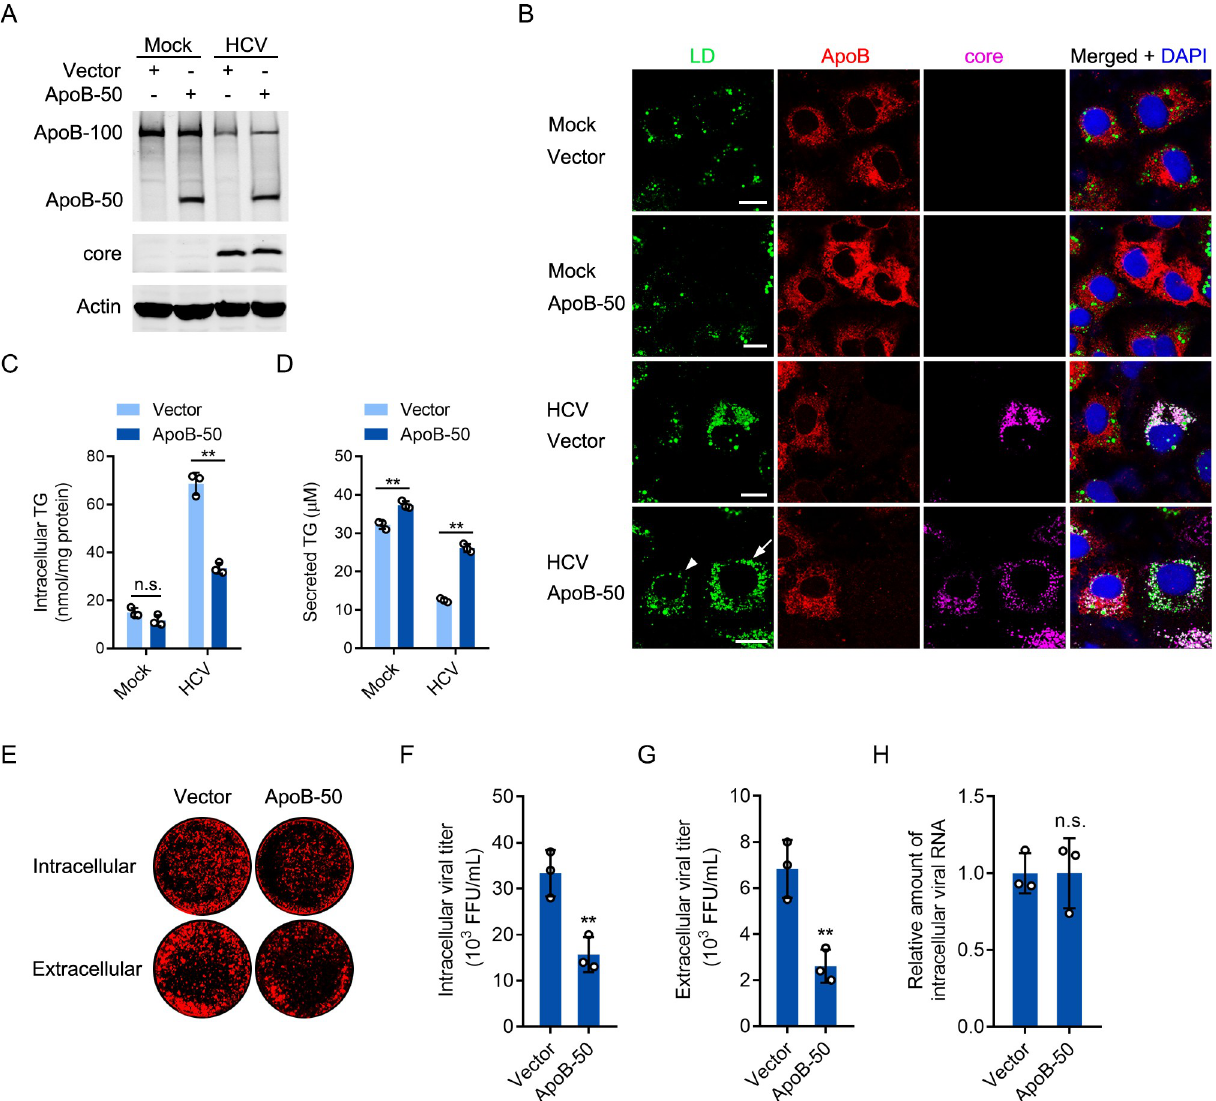
Fig 9. Expression of ApoB-50 decreased lipid accumulation and inhibited HCV production. (A) Huh-7 cells were infected with HCV (MOI = 1) for 2 days prior to transduction with ApoB-50 for 2 days. The protein levels of ApoB and the core were analyzed by western blotting. Actin was used as the loading control. (B) Immunostaining was performed in cells in A with antibodies against ApoB and core. LDs were stained with BODIPY 493/503. Nuclei were stained with DAPI. Fluorescence signals were visualized by laser confocal microscopy. The arrow indicates an HCV-infected cell. The arrowhead indicates an HCV-infected cell transduced with ApoB-50. Scale bars, 10 μ M. (C and D) The intracellular and extracellular TG concentrations in cells in A were analyzed using a TG quantification kit. TG, triglyceride. (E-G) Cell lysates and culture supernatants from HCV-infected cells were collected to infect Huh-7 cells. In-cell western blot analysis and viral titration assays were performed. (H) The intracellular HCV RNA level was analyzed by real-time PCR. GAPDH was used as the internal control. The statistical significance was determined by unpaired two-tailed Student’s t -tests. The data are shown as the means ± SDs of n = 3 biological repeats. n.s., not significant. �� P <